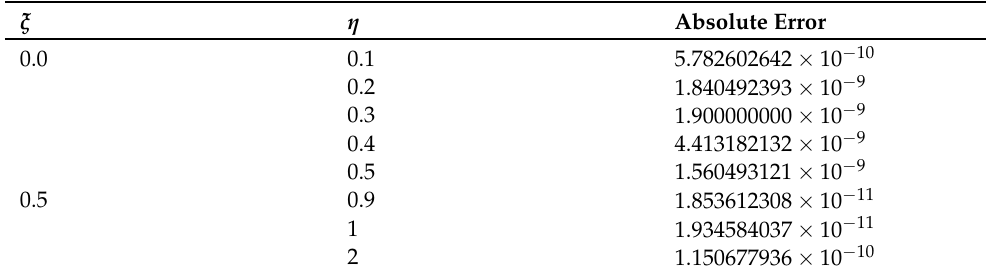
Table 1. The effects of the Mittag-Leffler parameters ξ and η on the error for Example 2 and N =